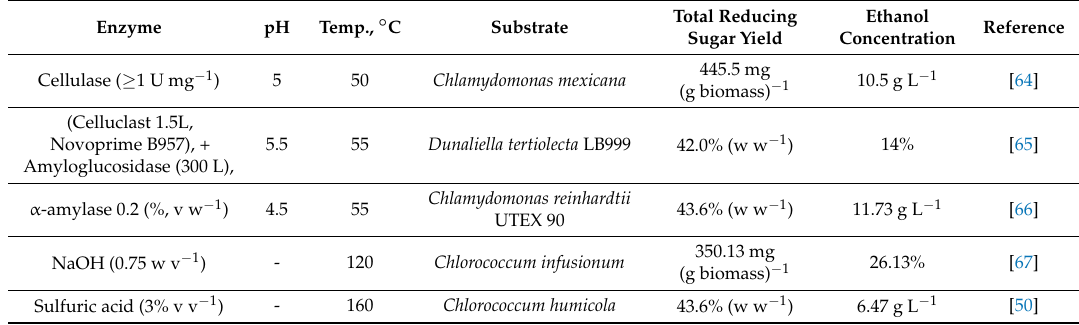
Table 3. Comparison of the results documented in earlier studies for total reducing sugar (TRS) release from microalgae using enzymatic treatment and subsequent bioethanol production. Enzyme Temp., ◦